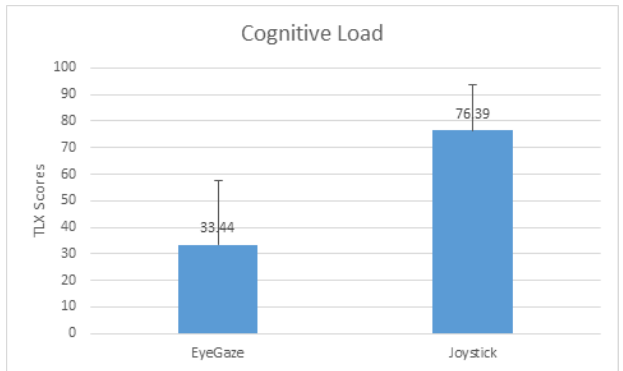
Figure 23. Comparing cognitive load in terms of average TLX scores.